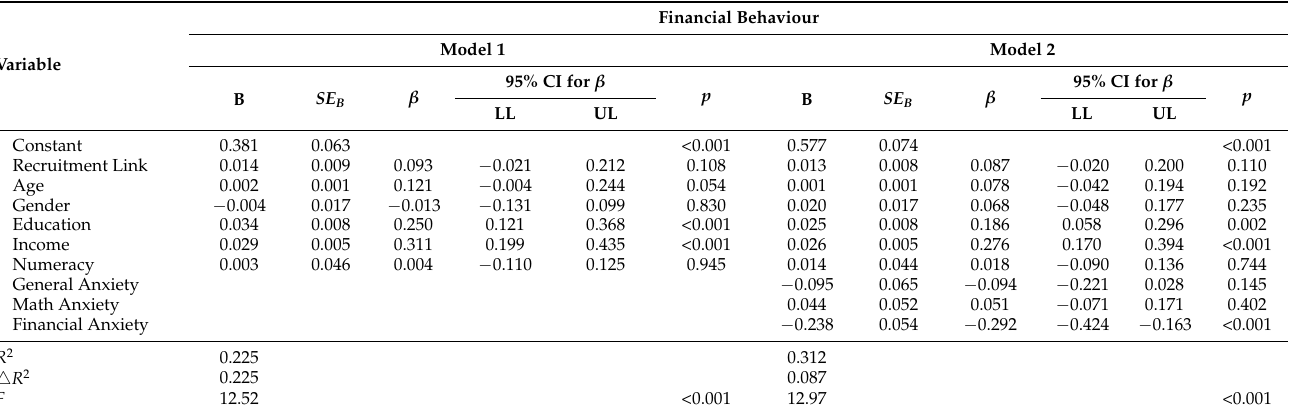
Table 5. Multiple Regression Assessing Factors Related to Financial